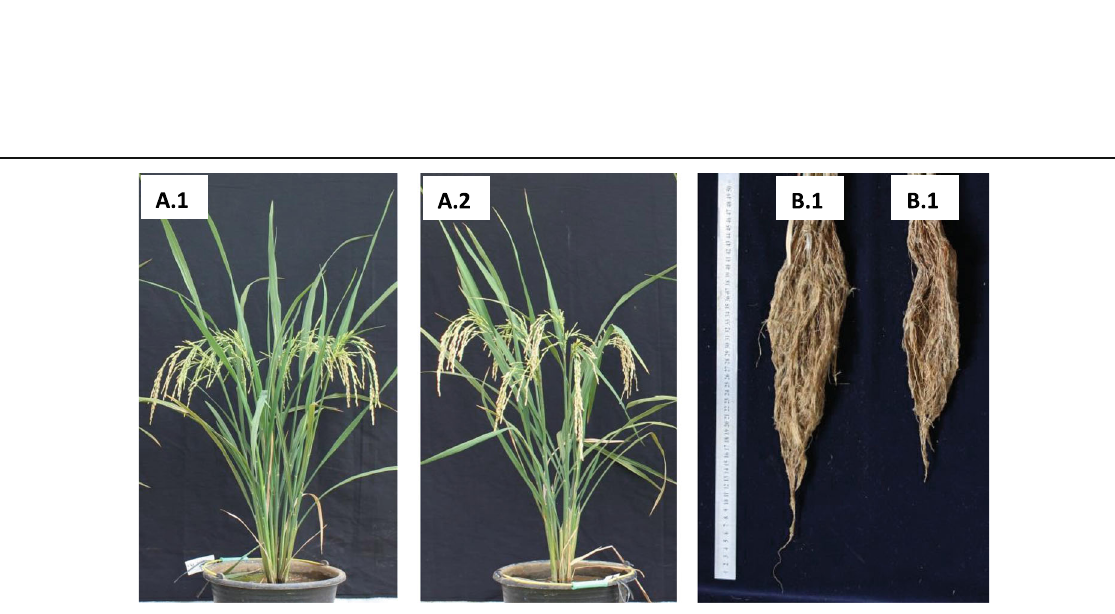
Fig. 3 Performances of T1 transgenic rice events and WT at harvest stage at the low N condition in the greenhouse. A1 = shoot of event FAM13, A2 = shoot of wild type, B1 = root of event FAM13, B2 = root of wild